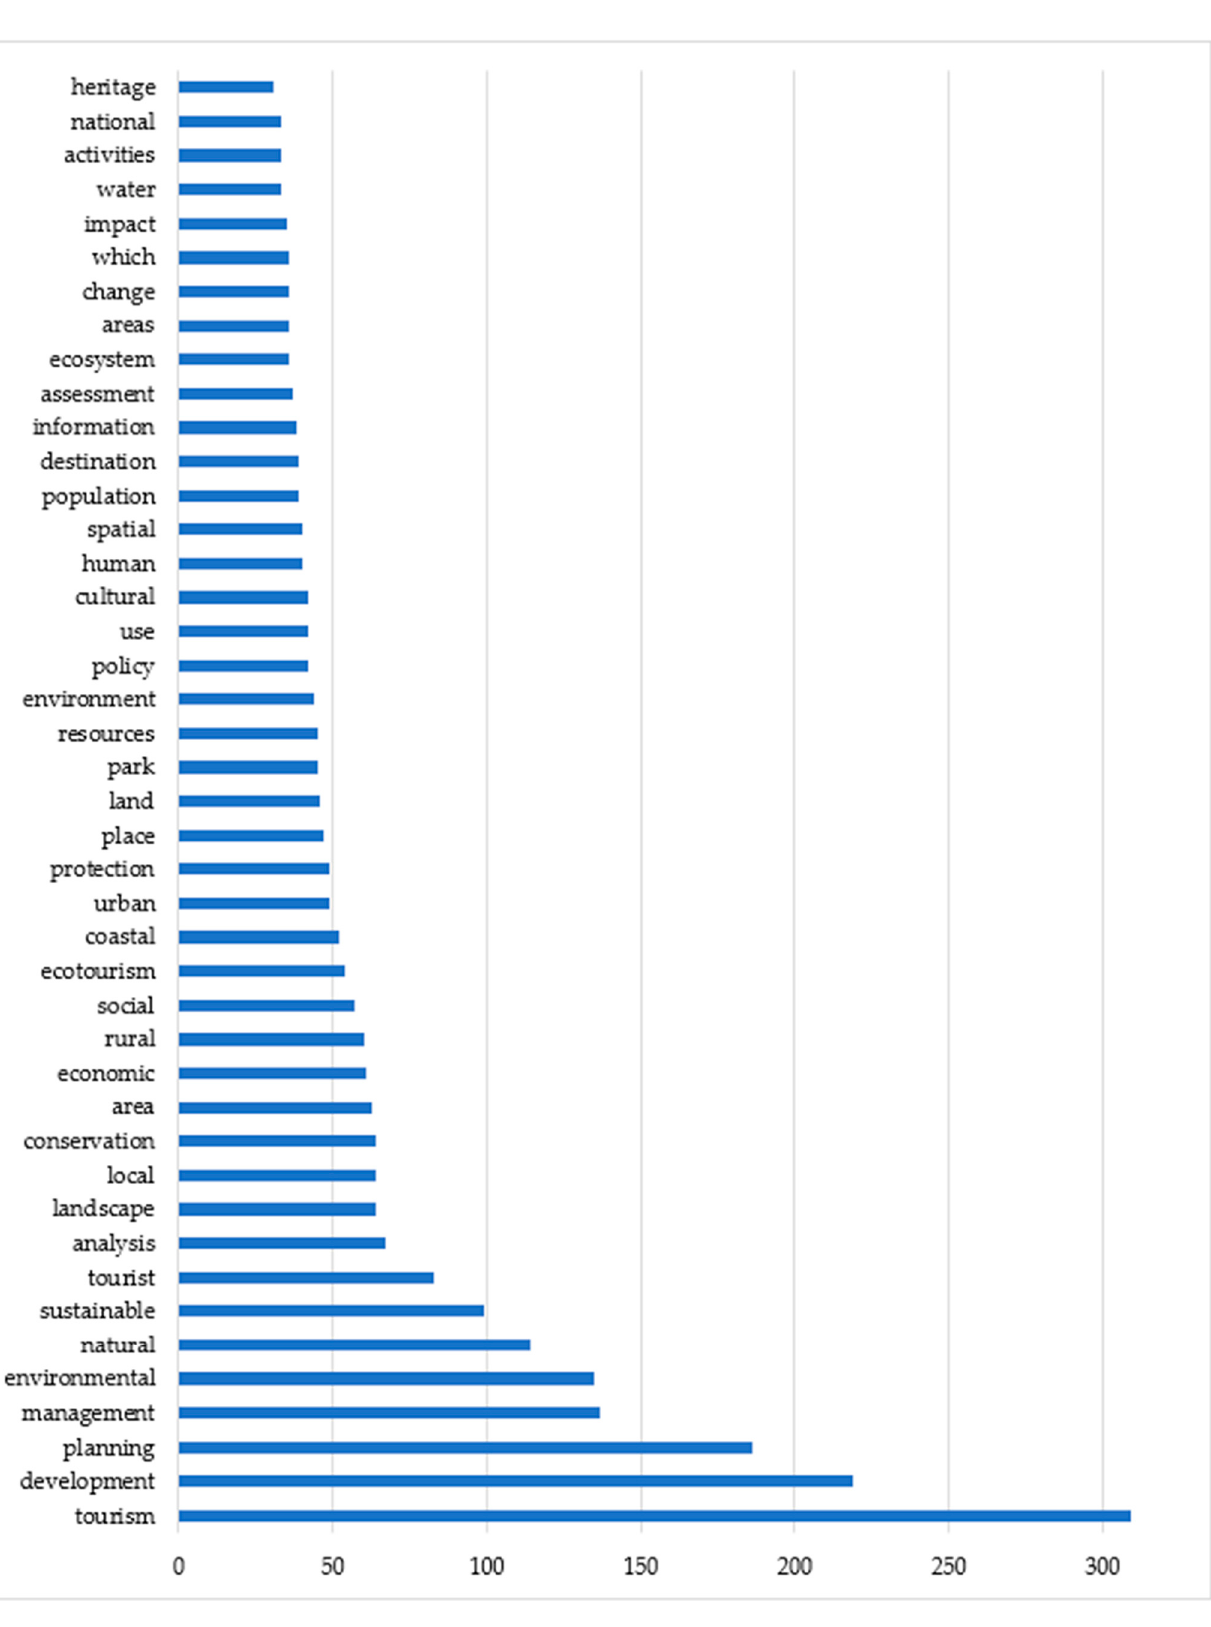
Figure 3. Most frequent words in paper titles .